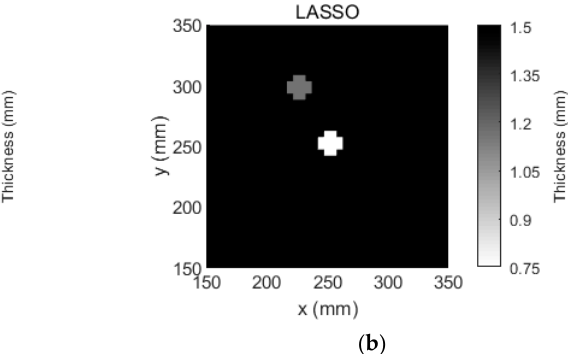
Figure 9. Tomographic reconstruction images for a 1.5 mm thick aluminum plate with two 20 mm diameter circular flat-bottomed holes with different grid density using SIRT. Their thickness losses were respectively of 50% and 30% within the flaws. ( a ) The number of grids was 20 × 20, ( b ) the number of grids was 40 × 40, ( c ) the number of grids was 60 × 60, and ( d ) the number of grids was 80 × 80.